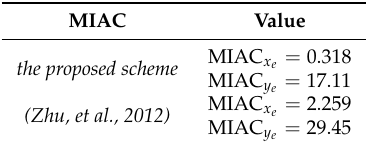
Figure 10. Virtual control law α u . Table 3. Performance index of